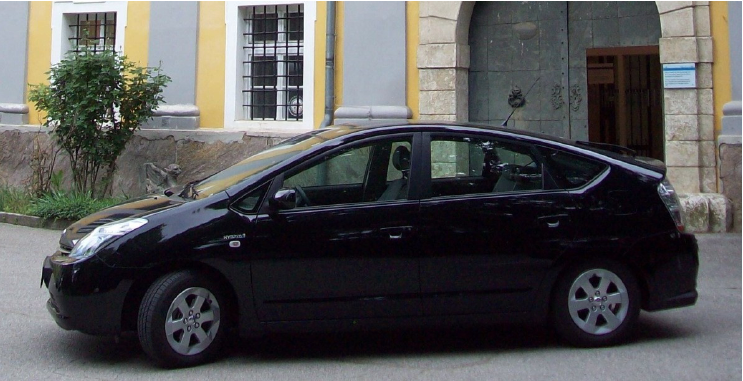
Figure 2. Curved shape of the roof of a Toyota Prius. Table 1. Longitudinal angles of PV cells on the roof of a Toyota Prius.